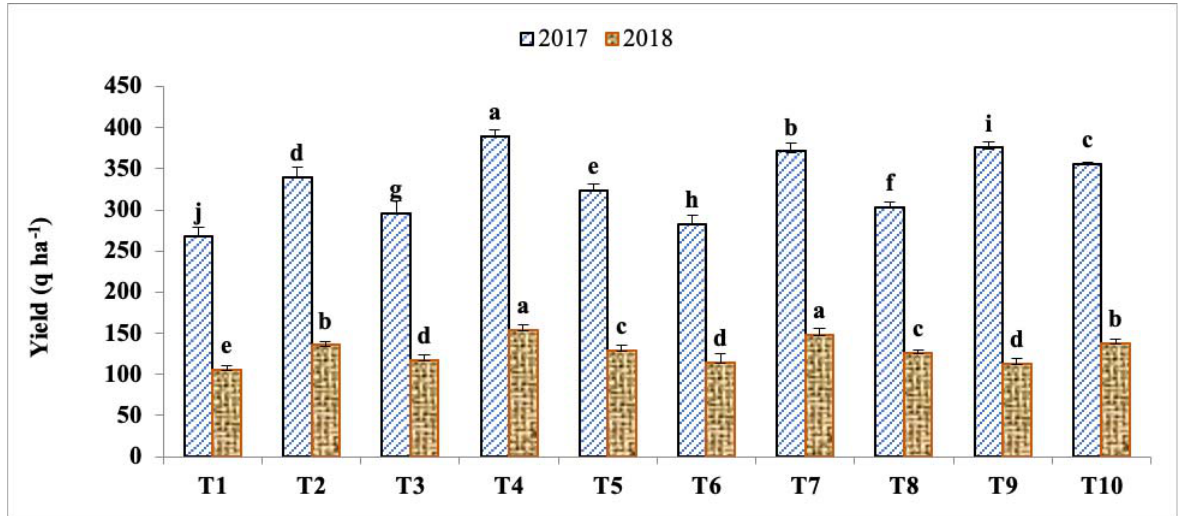
Figure 2. Effects of panchagavya, jeevamrut, and organic manures on the yield of brinjal. Treatment details are given in Table 1. Using Duncan’s multiple ranges test, the values with similar letters in superscript do not differ significantly at the 5% level.